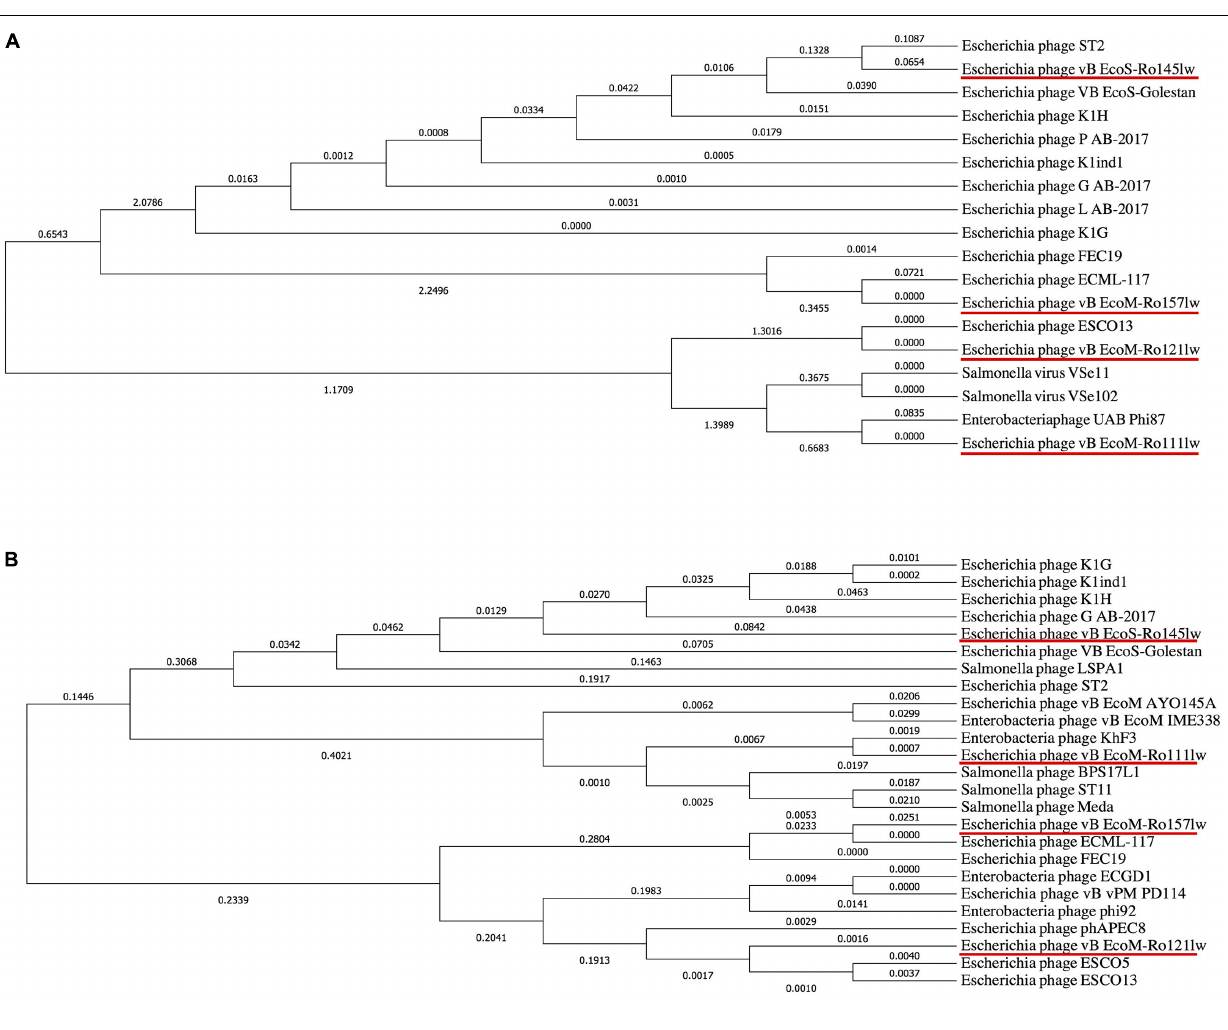
FIGURE 4 | Phylogenetic comparison based on Clustal Omega alignment of the genes coding for tail fiber (A) and endolysin/lysozyme (B) from the newly isolated phages (red underline) and other reference phage genomes obtained from NCBI database. The tree is drawn to scale, with branch lengths (next to the branches) in the same units as those of the evolutionary distances used to infer the phylogenetic